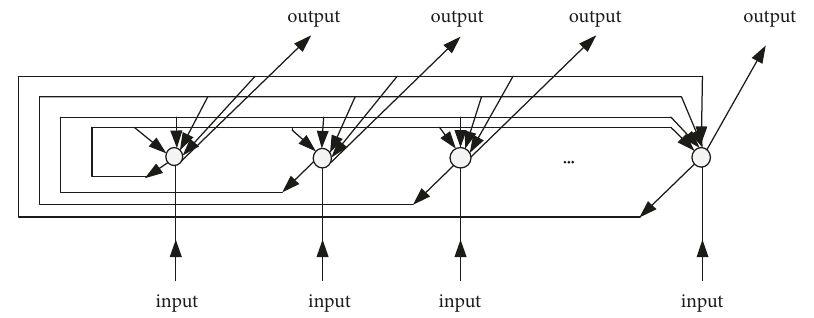
Figure 5: Full feedback neural network.